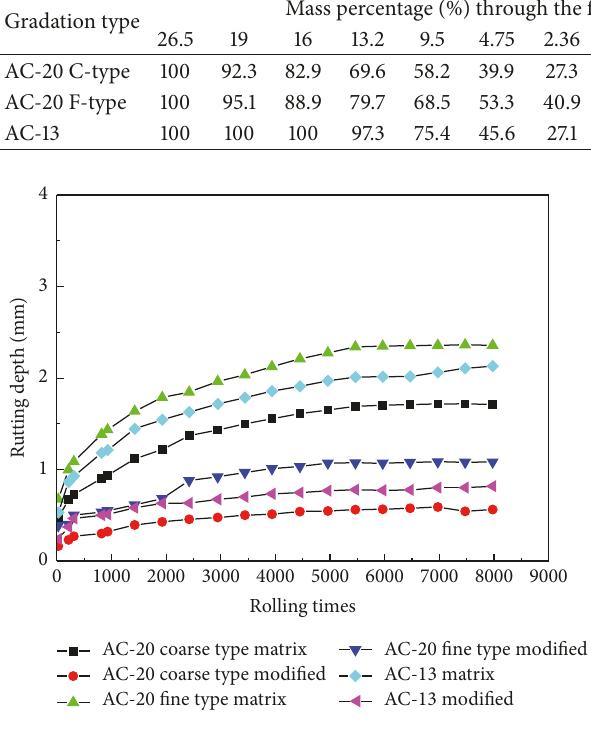
Figure 2: APA rutting depths of asphalt mixtures at 40 ∘ C under air- dry conditions.